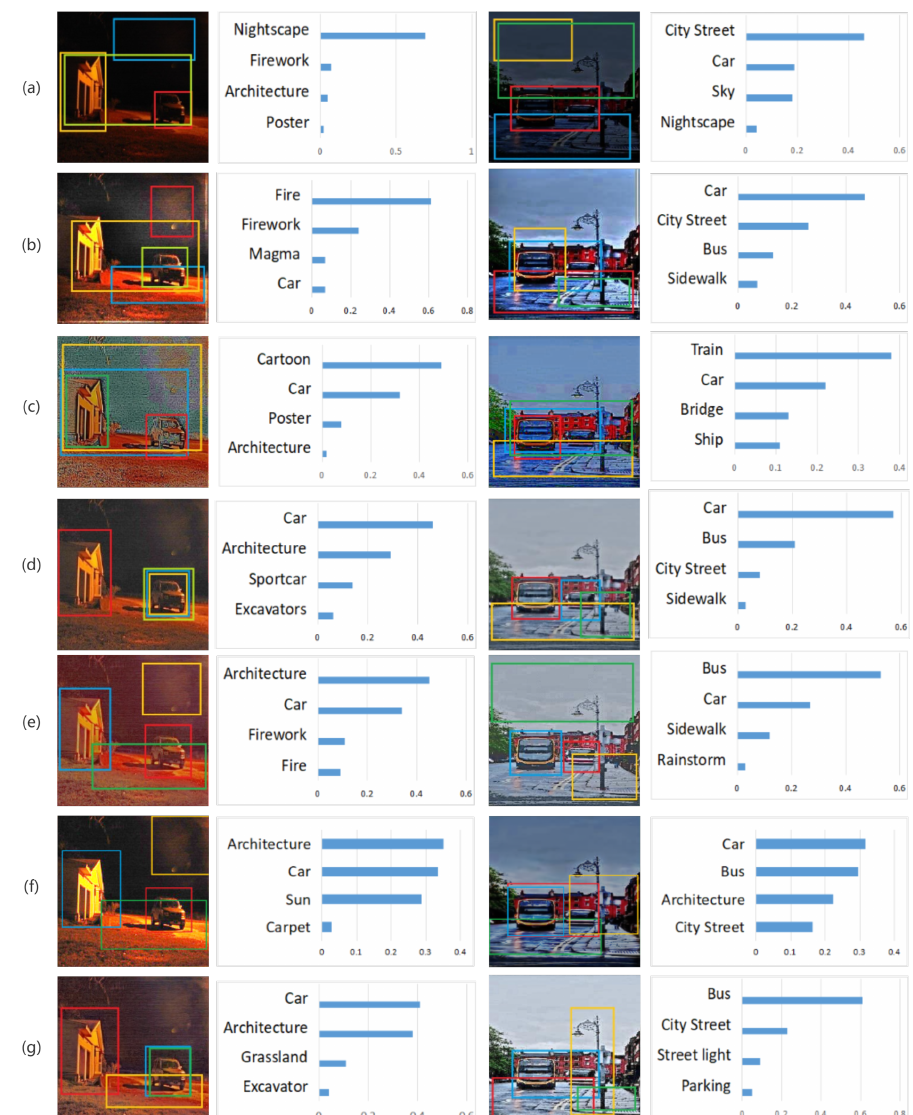
Figure 13. Top 4 object detection results of low-light image ( a ), enhanced by LIME ( b ), enhanced by RetinexNet ( c ), enhanced by CNN in stage 1 ( d ), enhanced by GP ( e ), KinD+ ( f ) and enhanced by our proposed method ( g ) using Yolov3 model. The detection rates from highest to lowest are: blue box, red box, yellow box and green box,